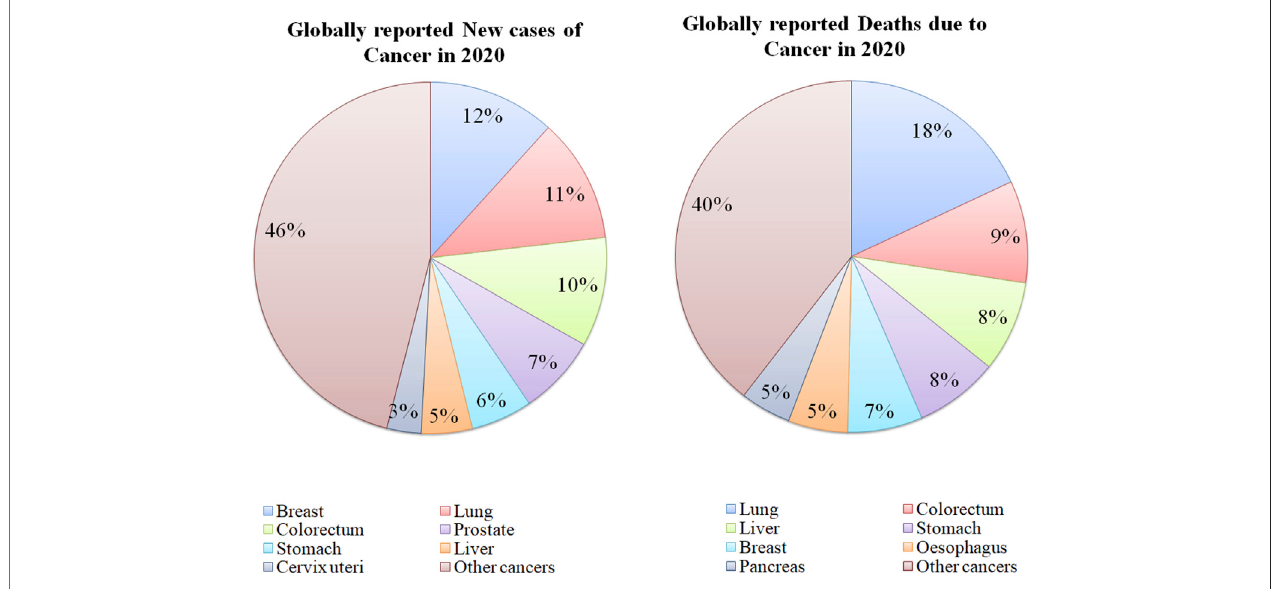
FIGURE 1 | Statistics of globally reported cases and deaths due to various types of cancers in 2020 [Data Collected from (WHO, 2021a)].